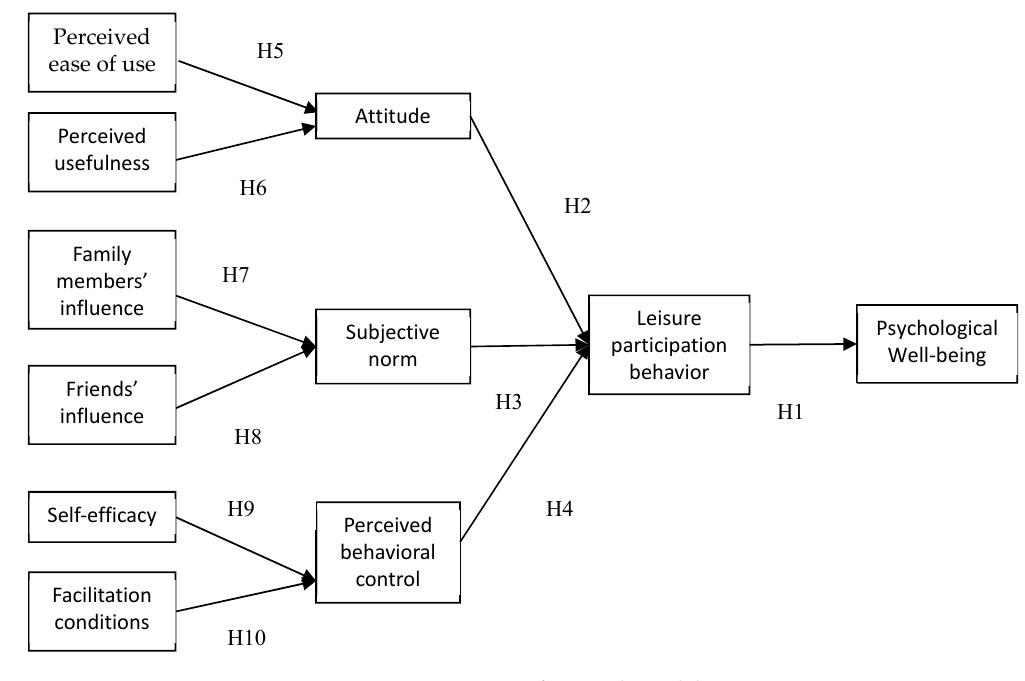
Figure 3. Concept of research model.